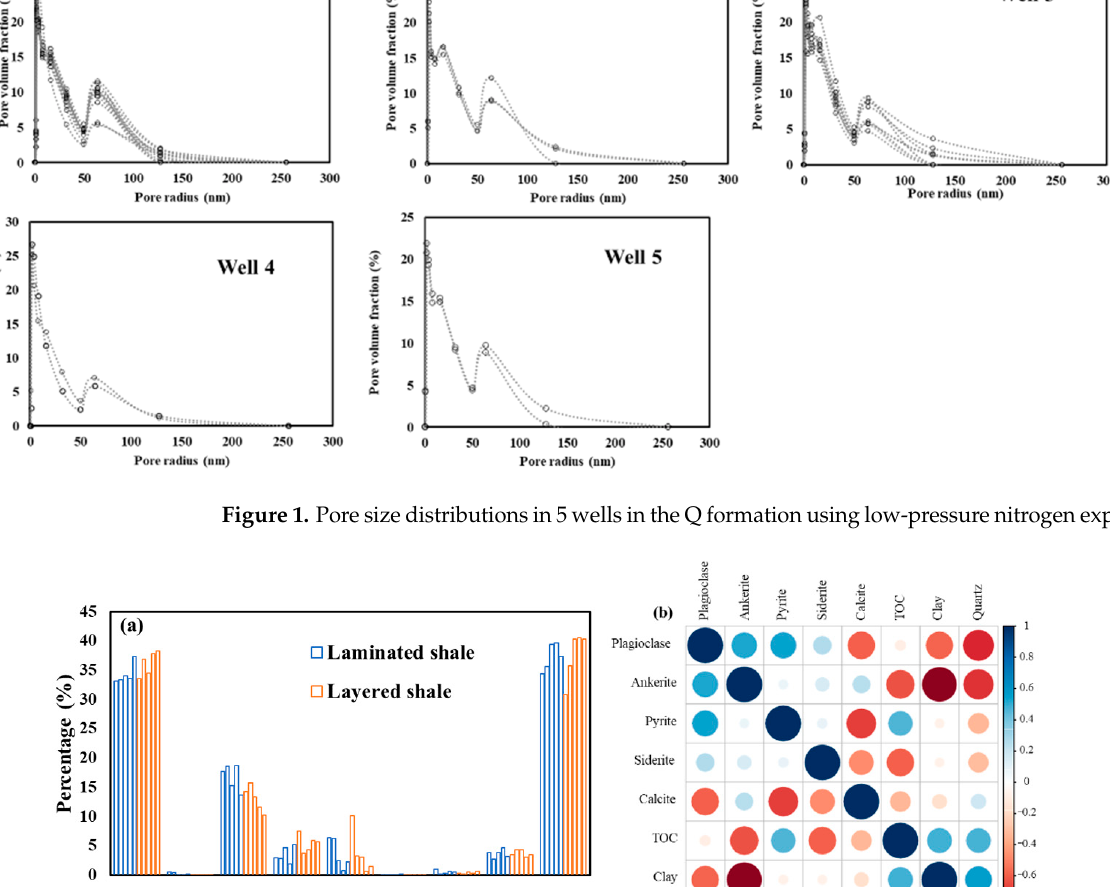
Figure 1. Pore size distributions in 5 wells in the Q formation using low-pressure nitrogen experiments.